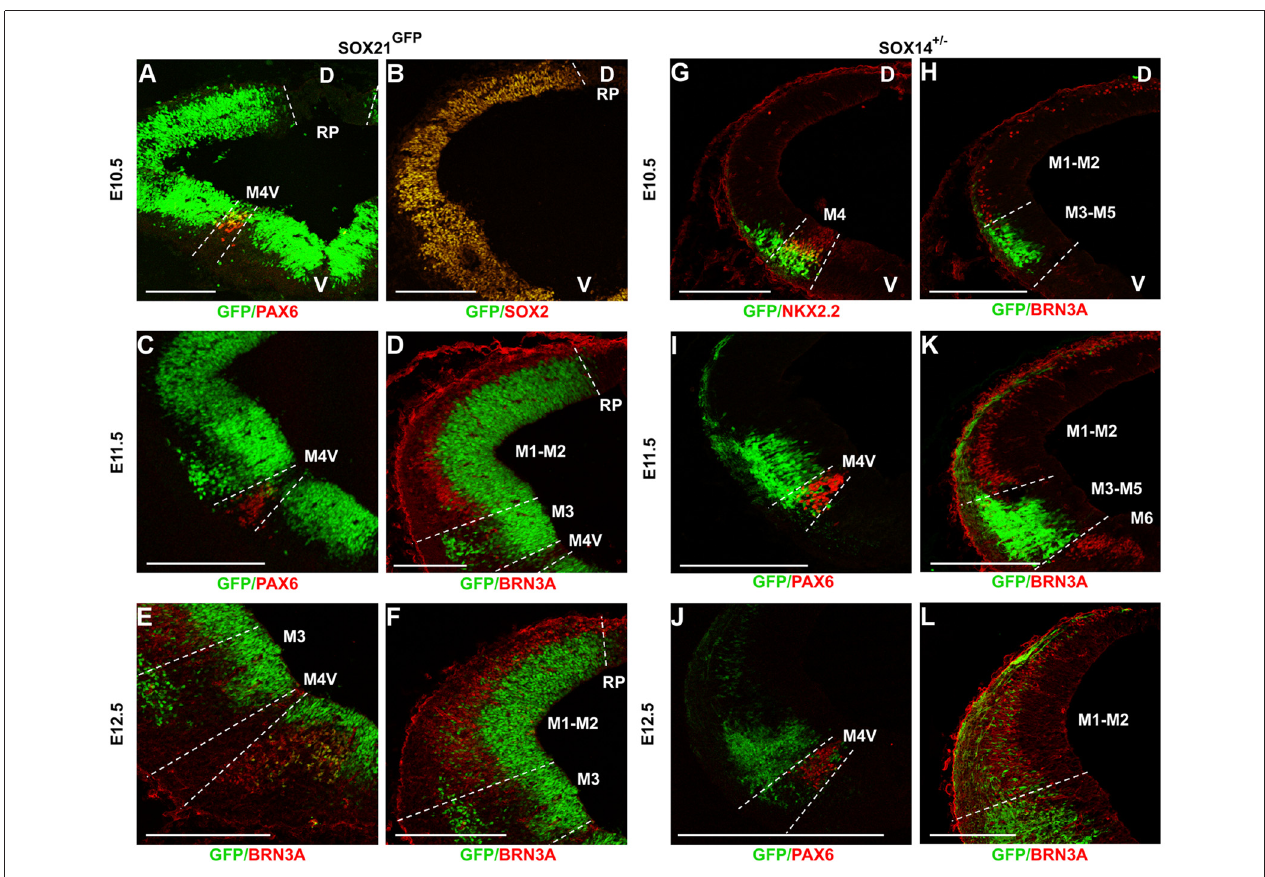
FIGURE 1 | Expression of the SOXB2 genes during early midbrain development. Midbrain coronal sections of SOX21 GFPn midbrains were immunostained at E10.5 (A,B) , E11.5 (C,D) and E12.5 (E,F) for the determination of the SOX21 expression during neurogenesis. Staining of E10.5 embryos with PAX6 (A) and SOX2 (B) illustrated that SOX21 is initially expressed throughout the ventricular zone (VZ) excluding the M4-V domain. At E11.5 a ventral population of SOX21 + ve cells emerges from the M3 domain of the VZ as shown by the expression of PAX6 (C) and BRN3A (D) . At E12.5 the SOX21 + ve cell population expands at the dorsal mantle zone (MZ) (E,F) . The expression of SOX14 was also mapped using midbrain coronal sections of SOX14 + / − embryos at E10.5 (G,H) , E11.5 (I,K) and E12.5 (J,L) . At E10.5 and E11.5 a ventral population of SOX14 + ve neurons emerges from the M3 and M4 domains of the VZ as shown by the expression of NKX2.2 (G) , PAX6 (I) and BRN3A (H,K) . At E12.5 the SOX14 + ve cell population expands at the dorsal MZ (J,L) . D—dorsal, V—ventral, Scale bar, 150 µ